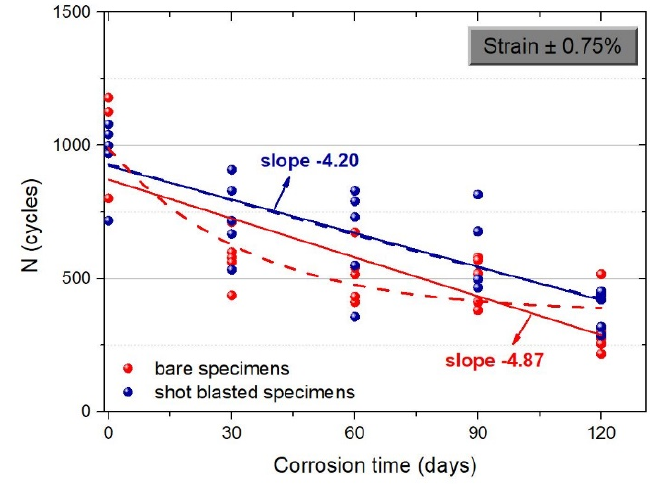
Figure 6. Fitting curves of number of cycles in function with corrosion time for imposed deformation ±0.75%.